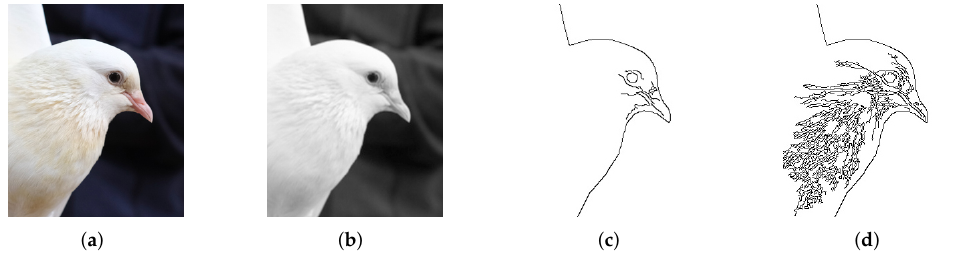
Figure 6. Extract outline information. ( a ) Original image. ( b ) Gray image. ( c ) Contour information obtained with Gaussian blur. ( d ) Contour information obtained without Gaussian blur.